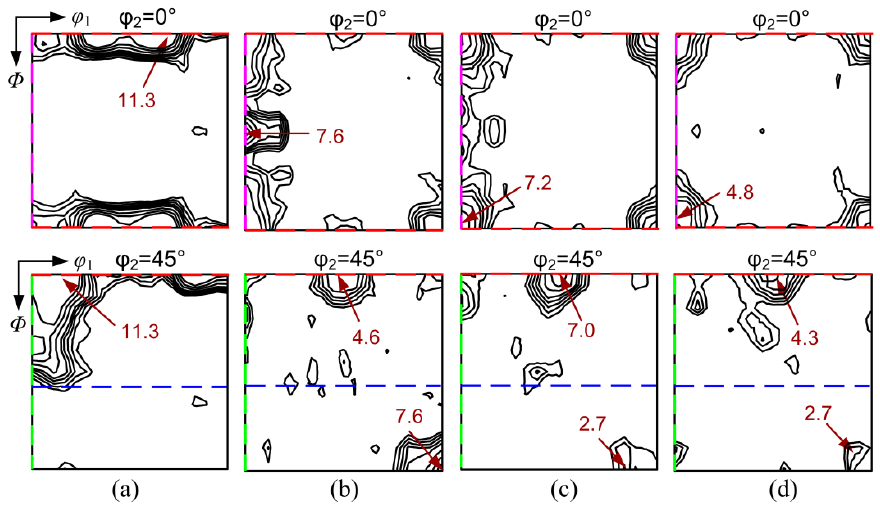
Figure 8. Macro-textures of ( a ) cold rolled sheet after first reduction; ( b ) 900 °C intermediately annealed sheet; ( c ) 1000 °C intermediately annealed sheet and ( d ) 1100 °C intermediately annealed sheet during two-stage rolling process.